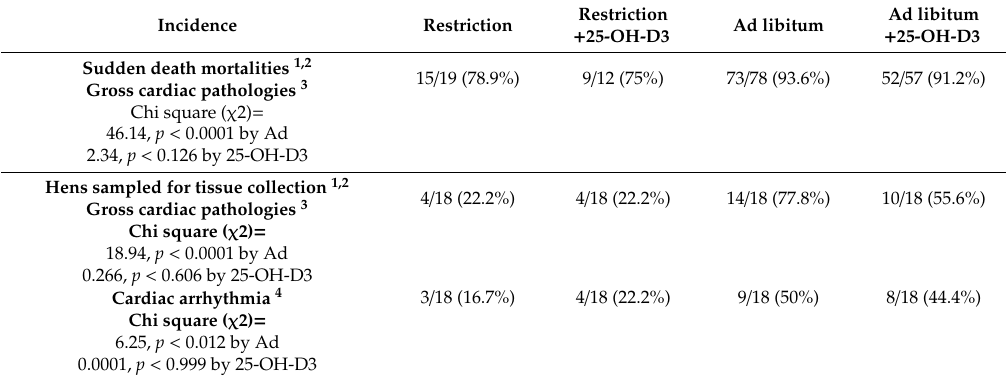
Table 1. E ff ect of dietary supplementation of 25-OH-D3 on the incidence of gross cardiac pathologies and arrhythmia in broiler breeder hens provided with restricted or ad libitum feed intake. Ad libitum Restriction Incidence Restriction + 25-OH-D3 Ad libitum + 25-OH-D3 Sudden death mortalities 1,2 15 / 19 (78.9%) 9 / 12 (75%) 73 / 78 (93.6%) 52 / 57 (91.2%) Gross cardiac pathologies 3